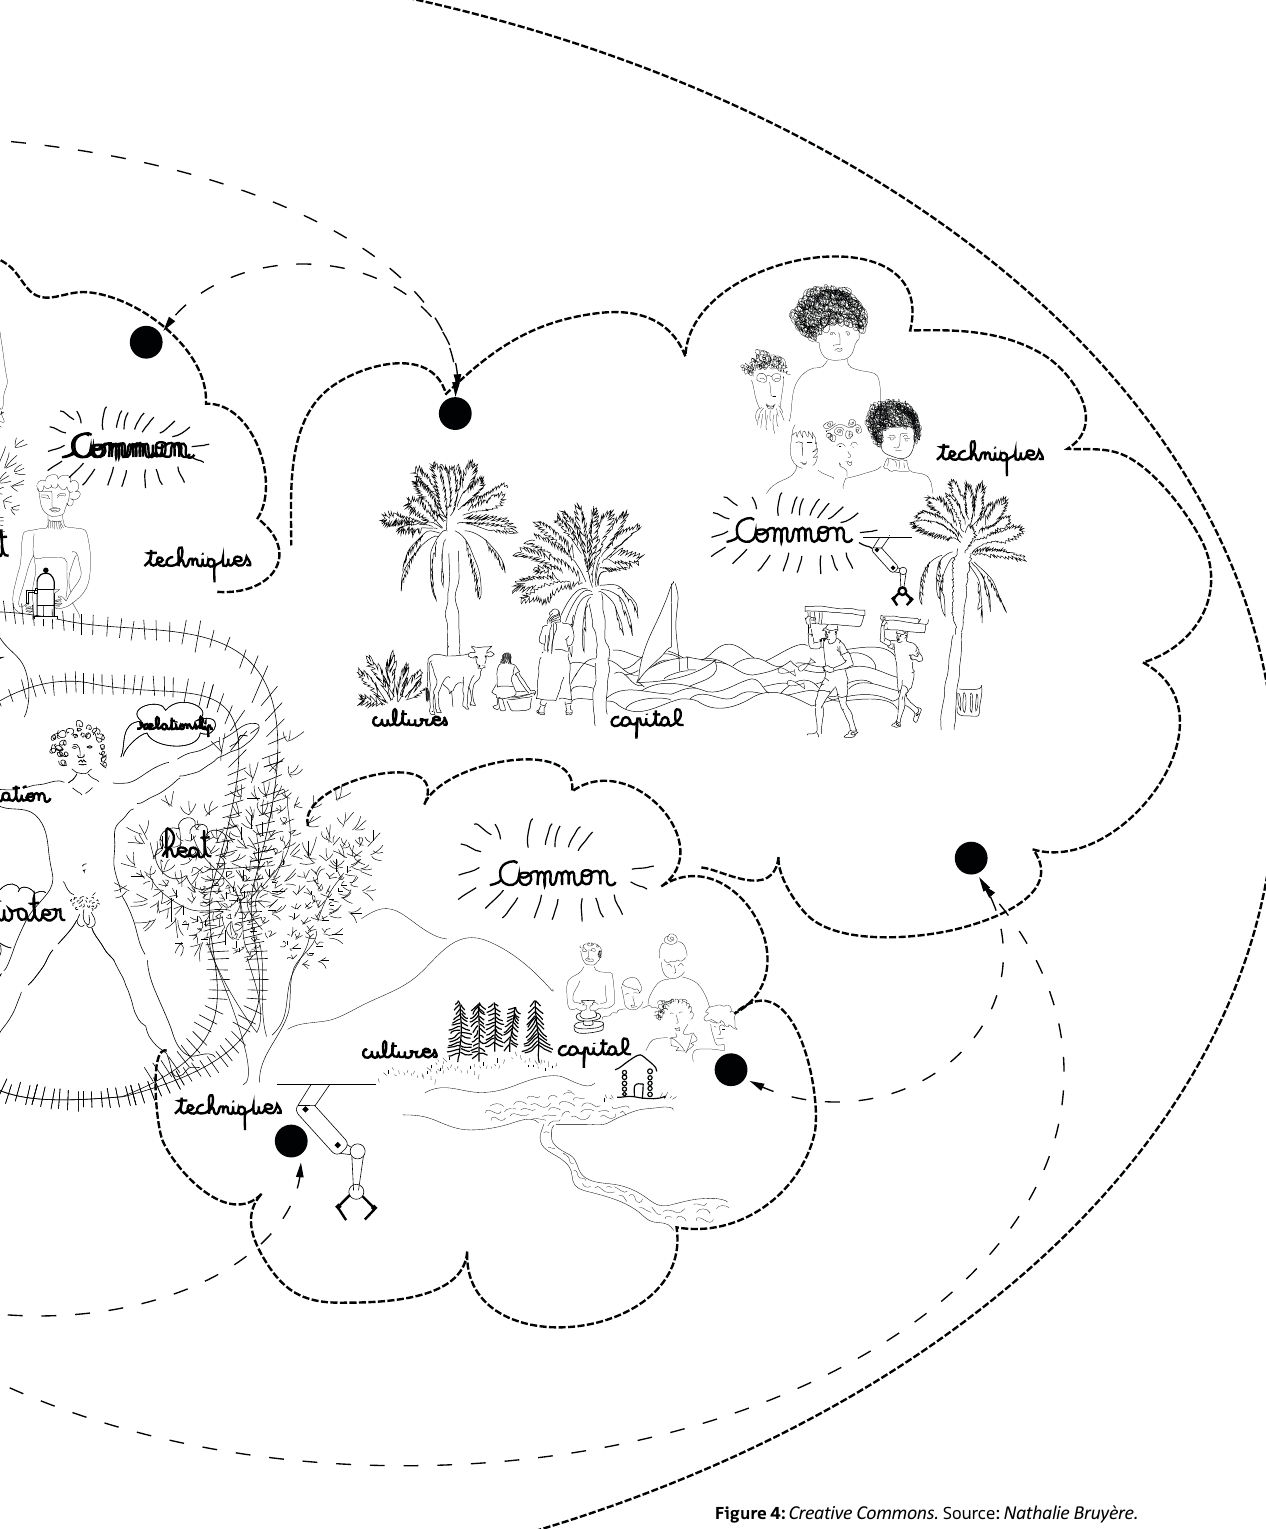
Figure 4: Creative Commons. Source: Nathalie